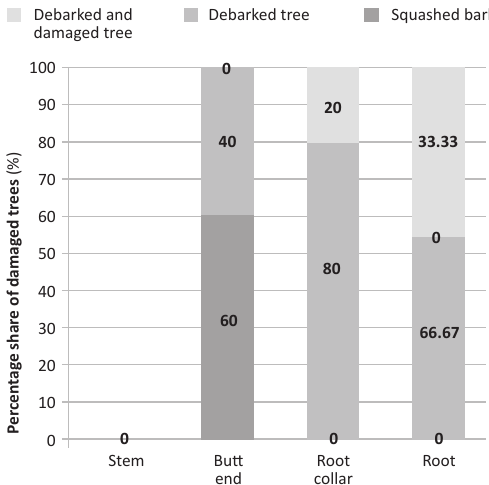
Debarked tree Squashed